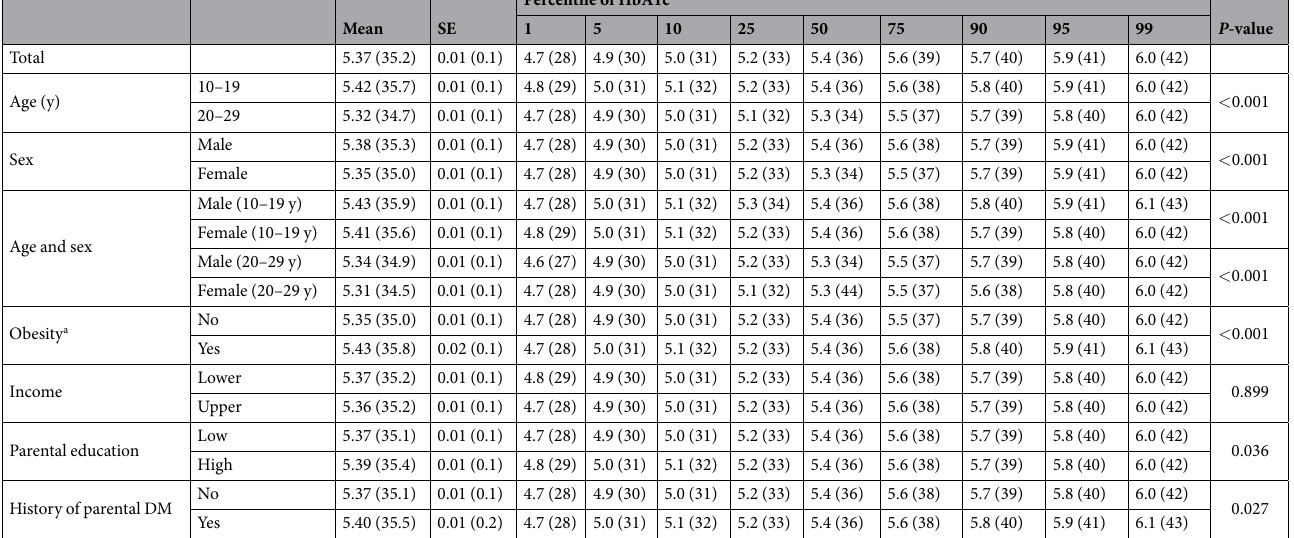
Table 2. Distribution of glycated haemoglobin (HbA1c) values by age, sex, and associated factors. HbA1c was described as NGSP, % (IFCC, mmol/mol). a Obesity: body mass index ≥ 95 th percentile for age and sex or body